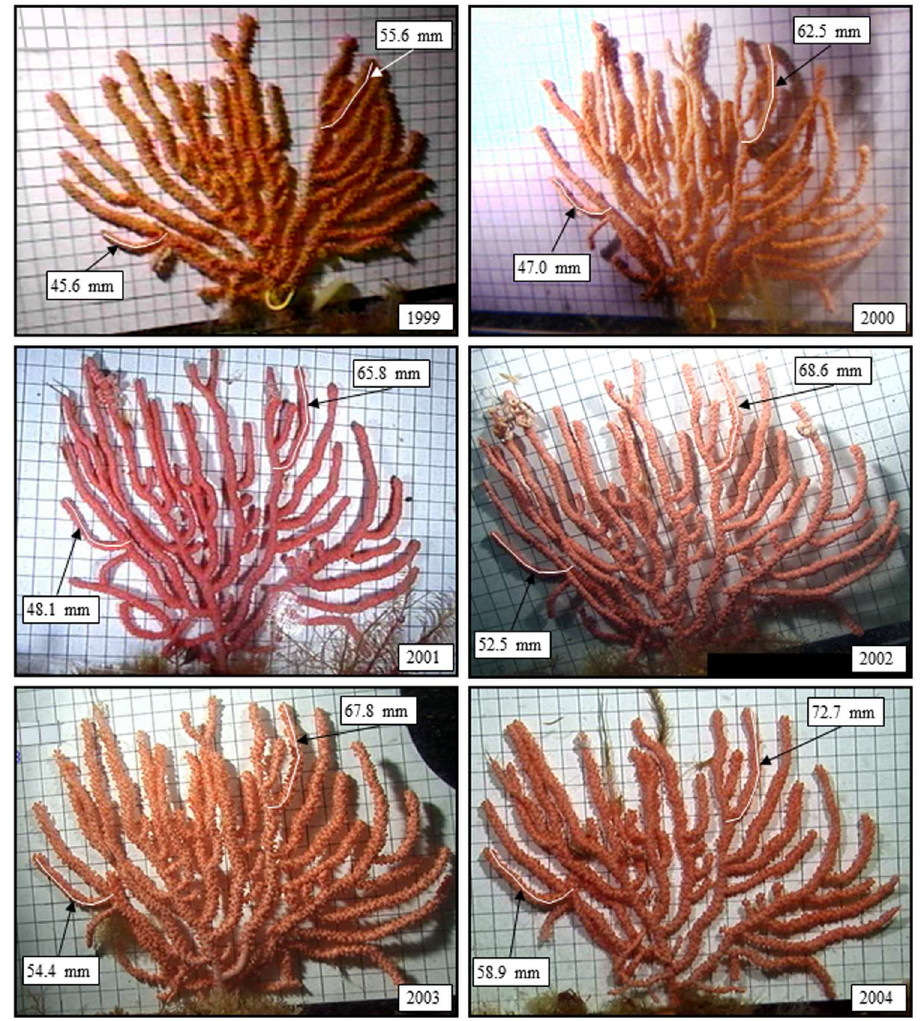
Fig 2. Series of photographs collected in situ of a coral colony at Site 1 showing the growth of two branches over a 5-yearperiod (1999–2004). Colonieswere video recordedwhilegently compressed betweena sheet of clear acrylic glass and a rigid vinyl 1-cm